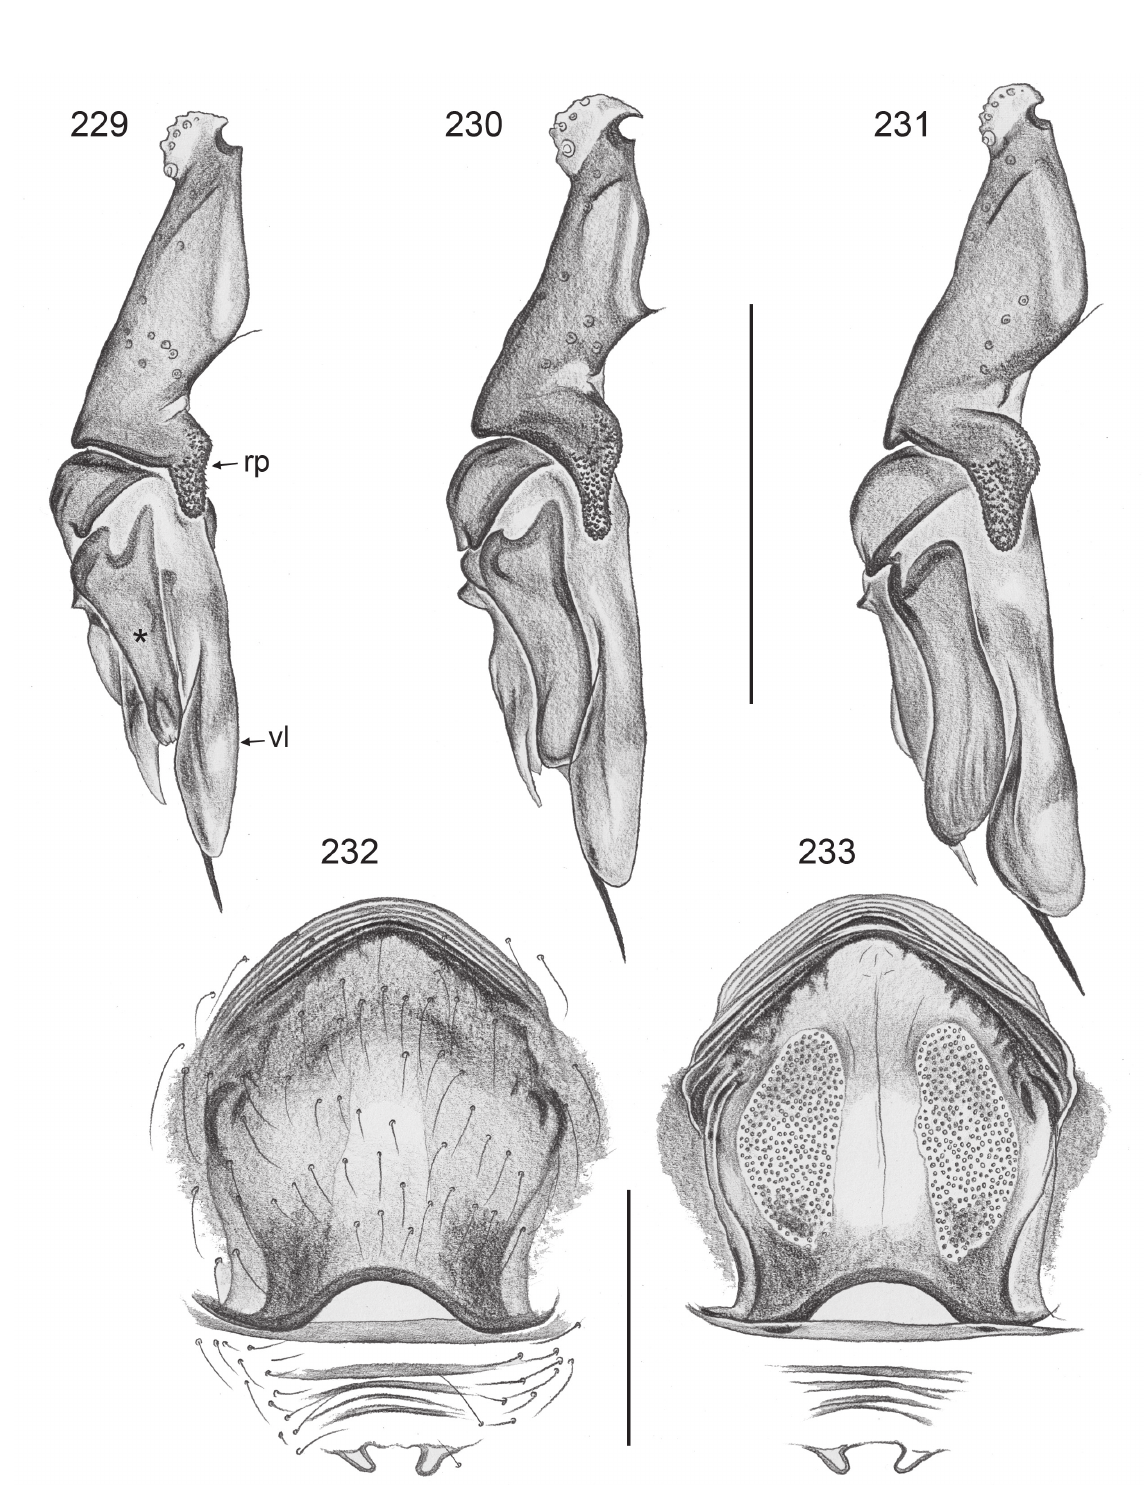
Figs 229–233. Left procursi, retrolateral views (asterisk: retrolatero-distal sclerite). — 229 . Aetana manansalai Huber, sp. nov. — 230 . A. lozadae Huber, sp. nov. — 231 . A. banahaw Huber, sp. nov. Figs 229–231 at same scale. — 232–233 . A. banahaw Huber, sp. nov., cleared female genitalia, ventral and dorsal views. rp = retrolatero-ventral process; vl = ventral lamina. Scale lines: